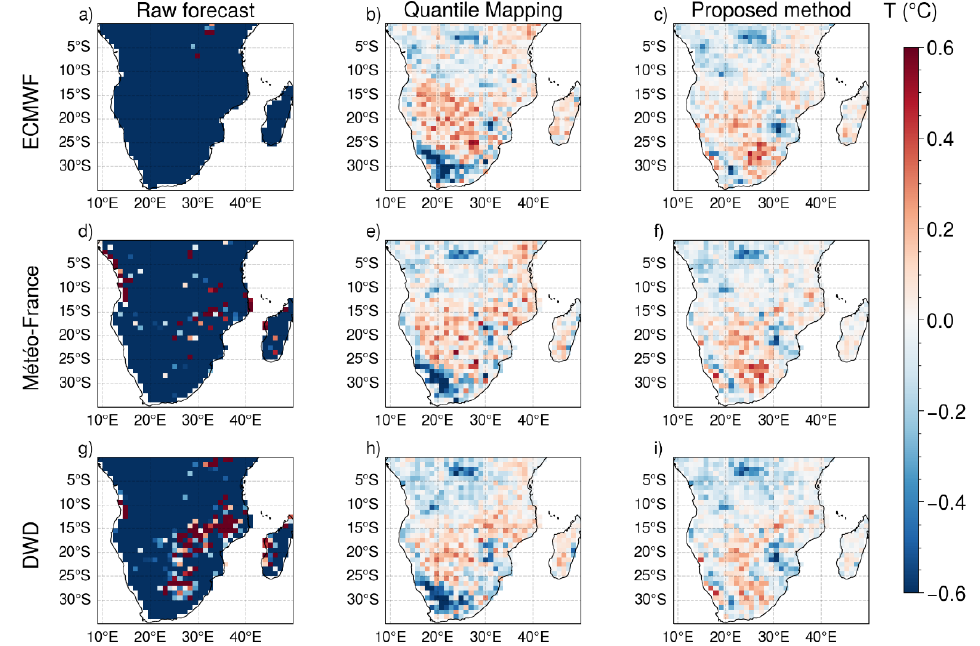
Figure 1. 2 m temperature extreme value corresponding to the difference between the 99th percentile for the three seasonal forecast systems SEAS5 ( a – c ), System7 ( d – f ) and GCFS2.1 ( g – i ), and the 99th percentile of ERA5 dat. The columns refer to the type of data: raw seasonal forecasts ( a , d , g ), seasonal forecast data corrected with quantile mapping ( b , e , h ), and seasonal forecast data corrected with the proposed bias correction method ( c , f , i ). Maps refer to January and lead time one.